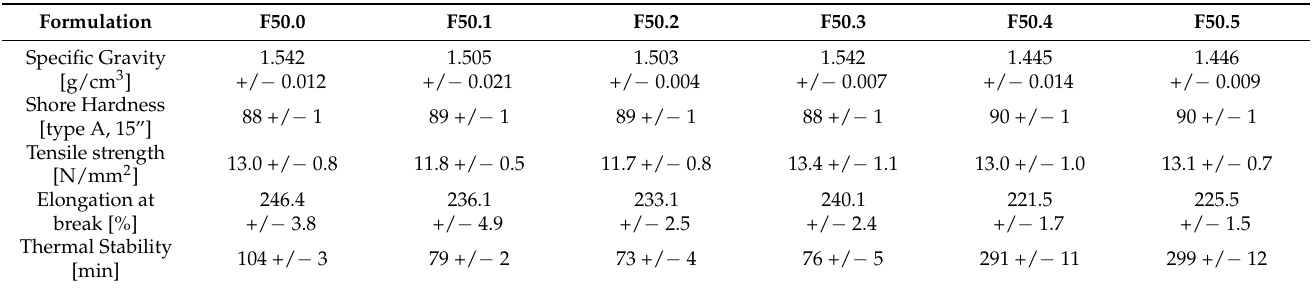
Table 7. Focus on the main properties of the compounds. The mean values and the standard deviations are reported.